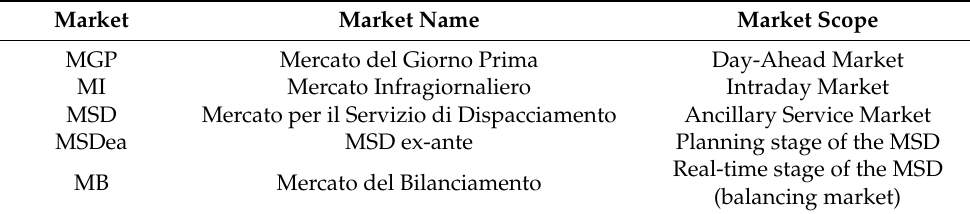
Table 1. List of spot market sessions. Market Market Name Market